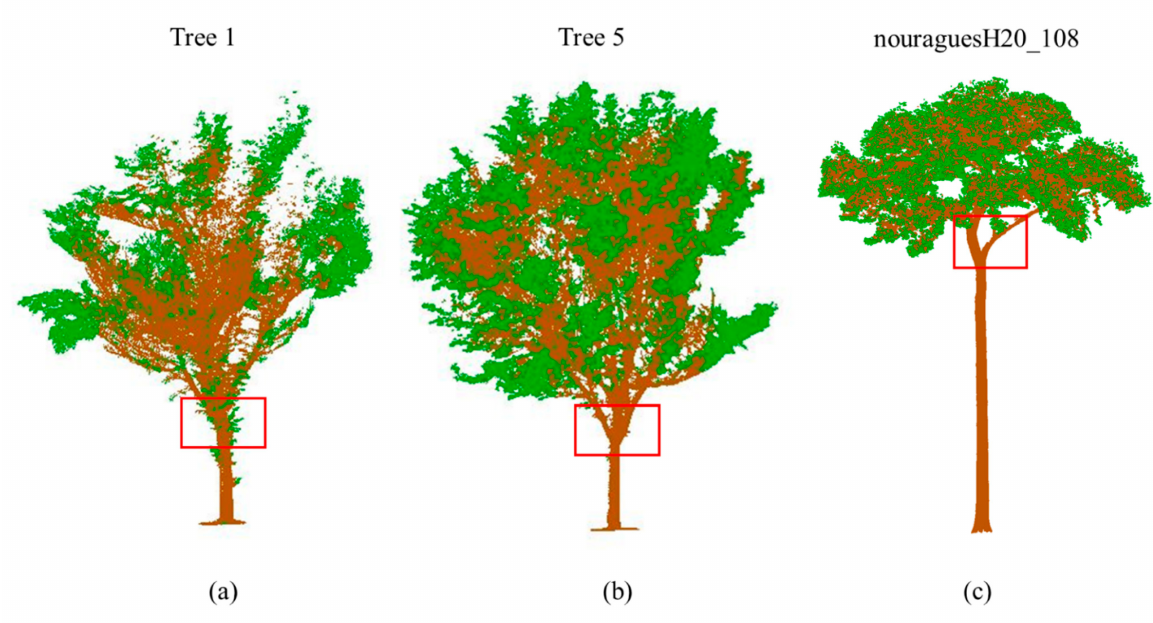
Figure 7. The multivariable time series (MTS) model of fully convolutional networks (FCN) prediction for Tree 1 ( a ), Tree 5 ( b ), and nouragueH20_108 ( c ) after manual intervention; the red square highlights the area where we make manual